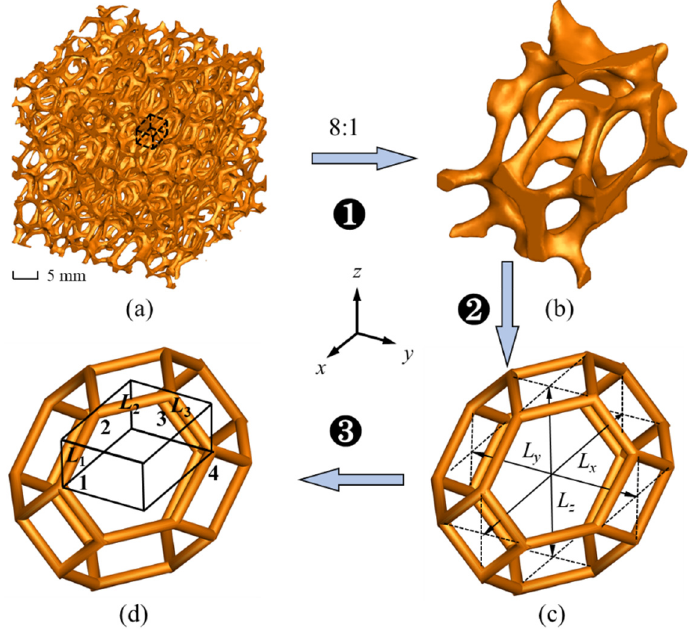
Figure 1. The process of representative cell selection and geometric modeling; ( a ) The 3D microstructures of ligaments; ( b ) A real cells of foam structures cut from the original copper foams randomly; ( c ) A simplified anisotropic tetrakaidekahedron formed by nodes and ligaments; ( d ) The schematic diagram of hexahedron representative unit selection.